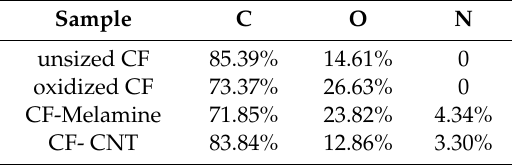
Table 2. The relative content of surface elements of di ff erent treated carbon fibers.